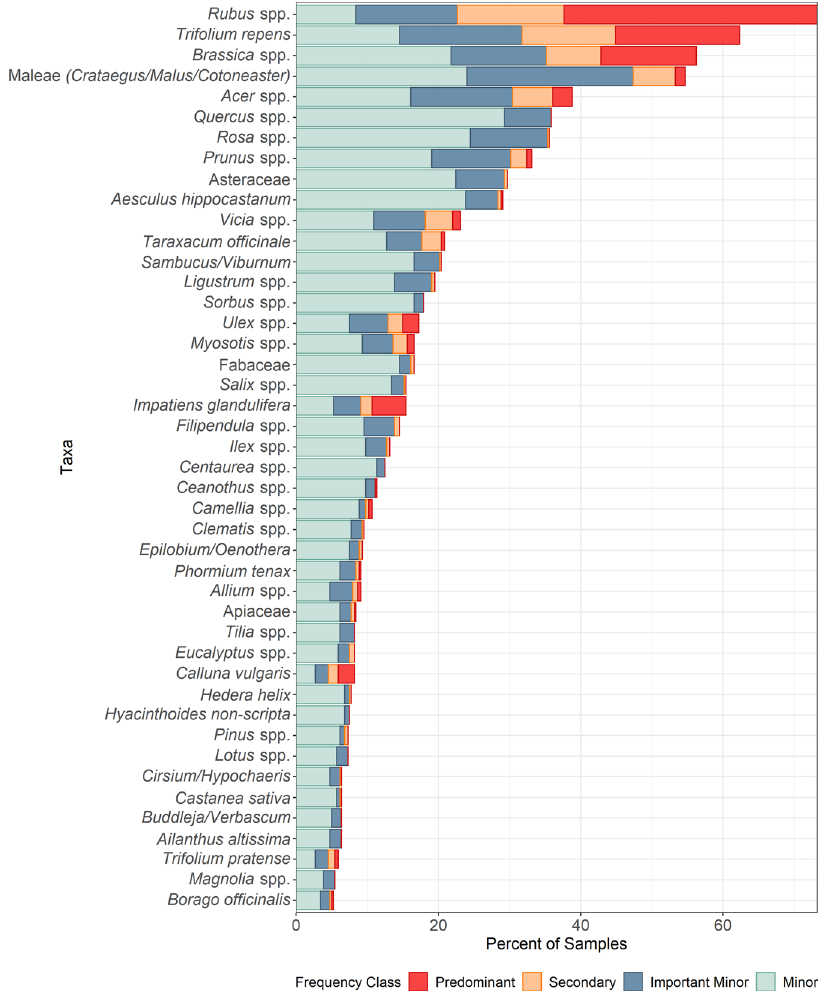
Fig. 2 Plant taxa found in over 5% of honey samples analysed using DNA metabarcoding ( n = 441). The abundance of a plant taxon within a honey sample is indicated by the colour, with four abundance classes: Predominant: >45% of sequences returned in a sample, secondary: 15 – 45%, important minor: 1 – 15% and minor